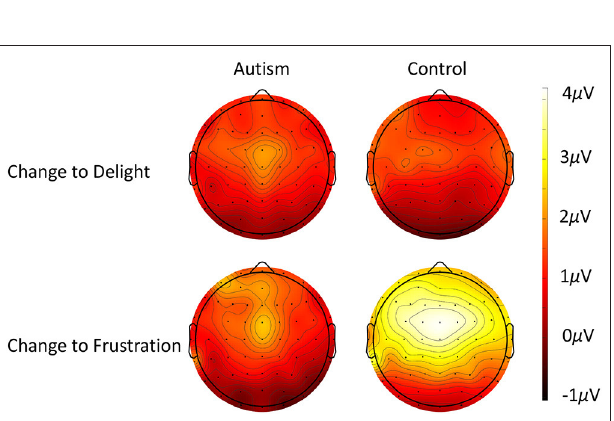
FIGURE 8 | Scalp topography of the P3 response to when the utterance changed from frustration to delight (top row) and when the utterance changed from delight to frustration (bottom row) for autism (left column) and neurotypical controls (right